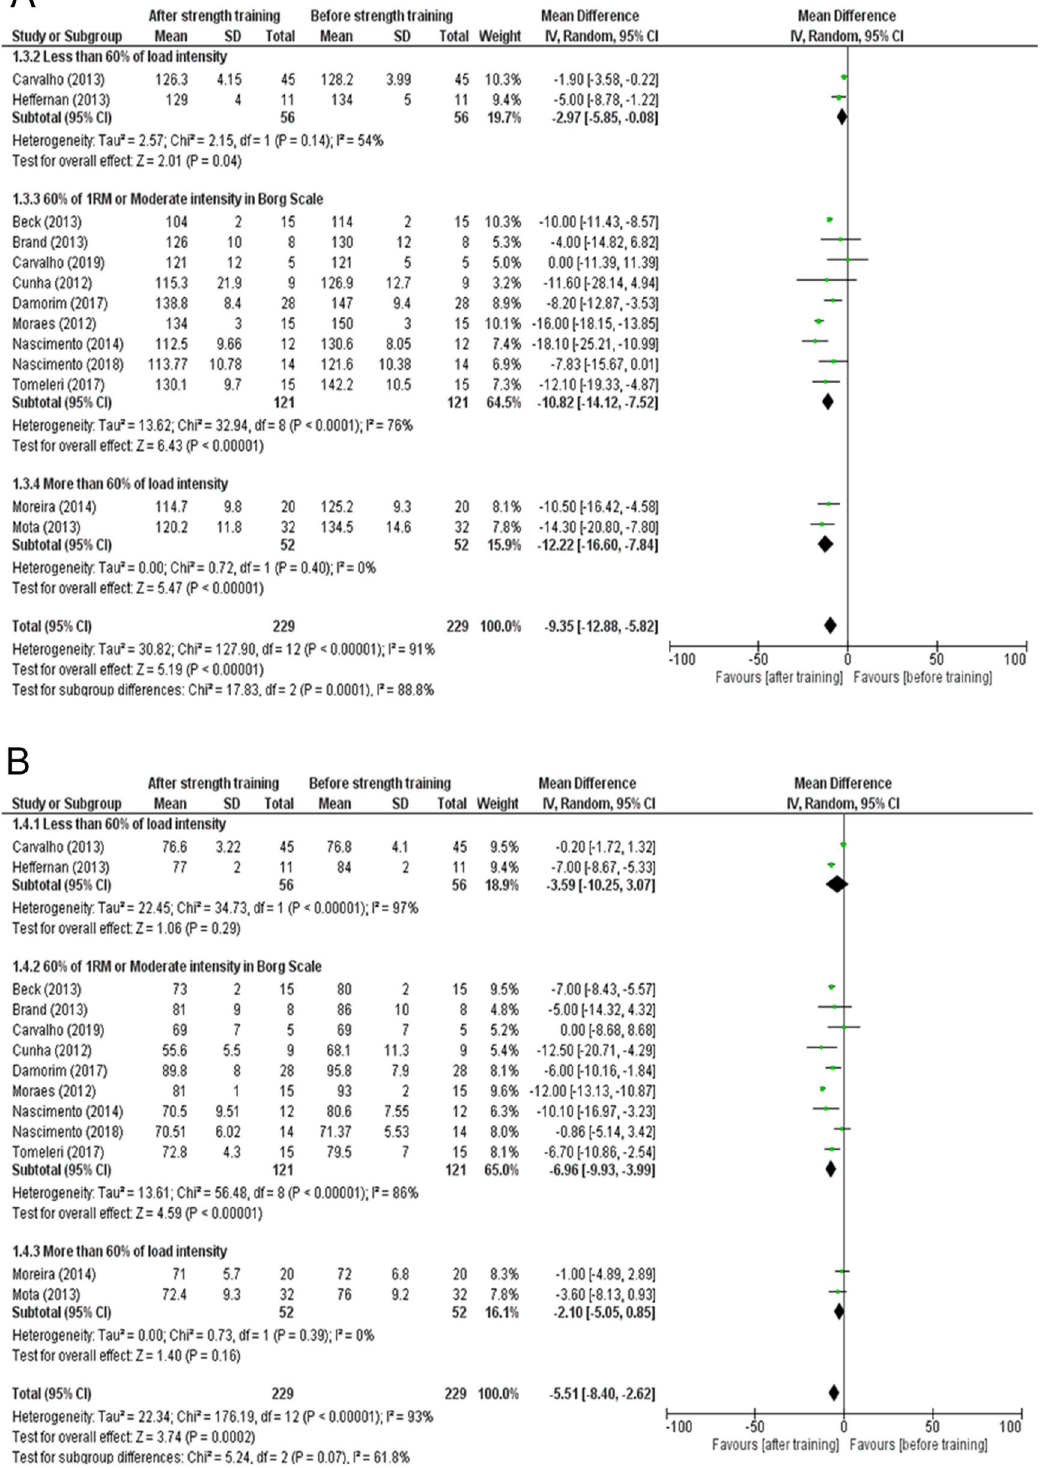
Figure 4. ( A ) Effects of strength training on systolic blood pressure in hypertensive individuals with less than 60% load intensity, 60% moderate Borg scale, and more than 60% of load intensity. ( B ) Effects of strength training on diastolic blood pressure in hypertensive individuals with less than 60% of load intensity, 60% moderate Borg scale, and more than 60% of load